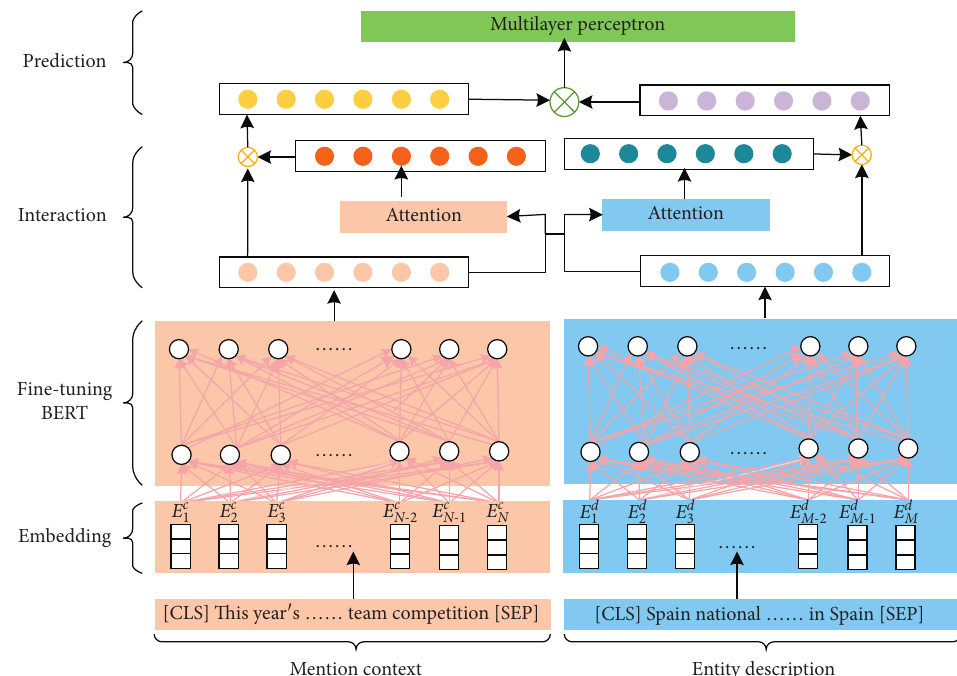
Figure 2: Architecture for entity linking based on sentence representation, where and denote multiple operations between two vectors.